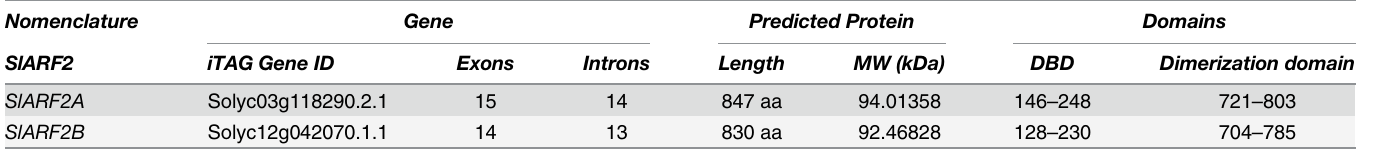
Table 1. Main structural features of the tomato SlARF2A and SlARF2B .